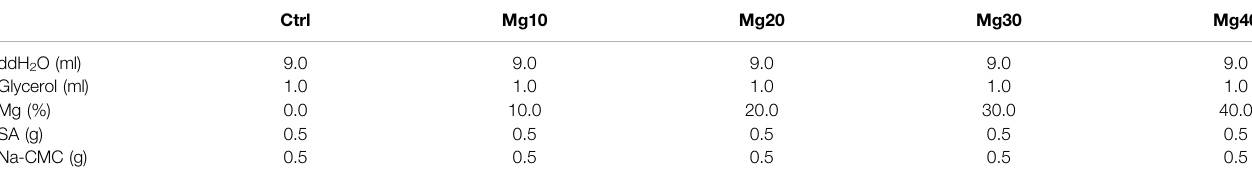
TABLE 1 | The composition list of MgSO 4 /MgO/SA/Na-CMC composite hydrogels. Ctrl Mg10 Mg20